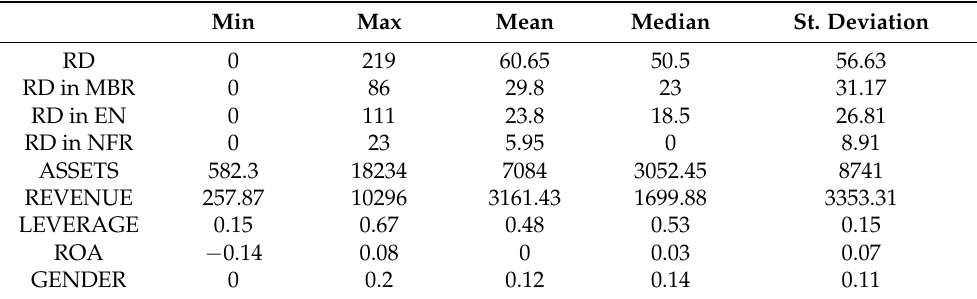
Table 2. Descriptive